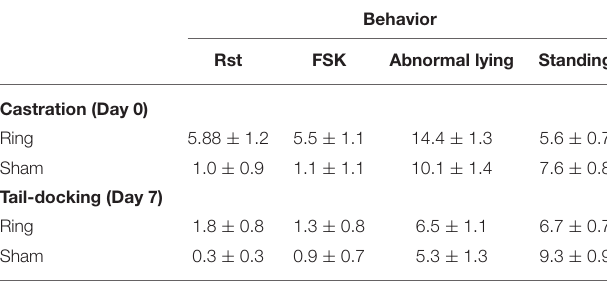
TABLE 2 | Mean count (mean ± SEM) of acute pain and postural behaviors related to pain for lambs in the Sham ( n = 15) and Ring ( n = 16) treatment groups following castration and